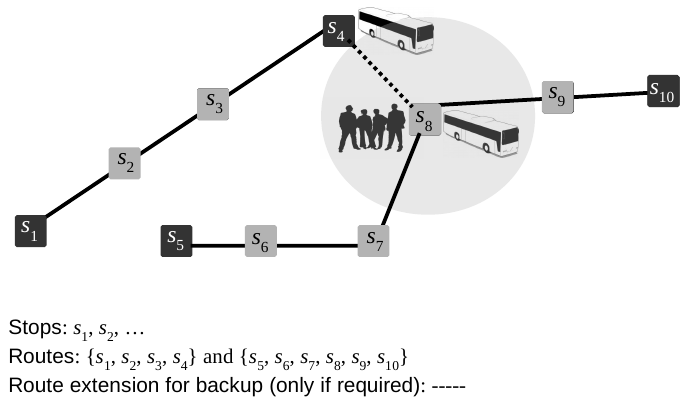
Figure 2. Illustration of vehicle routing problem with reactive response to